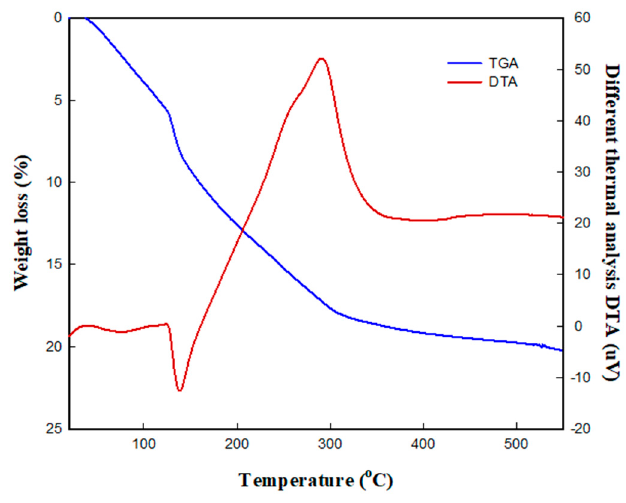
Figure 2. DTA-TGA curves of copper sludge sample.